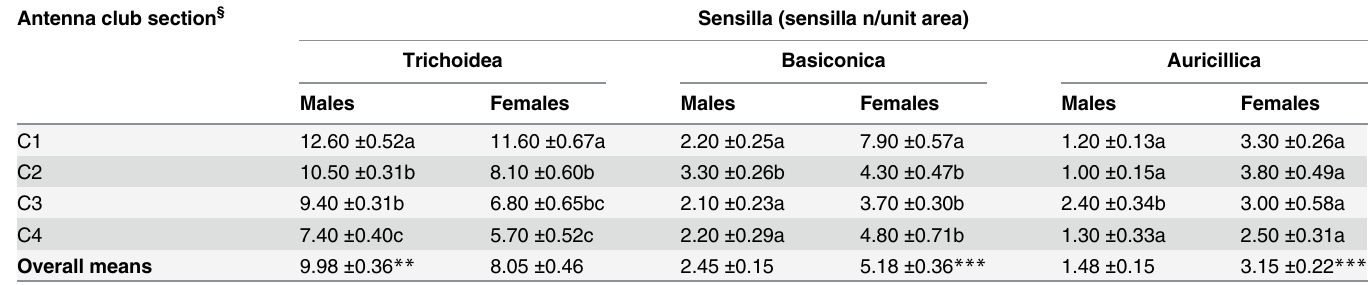
Table 2. Sensilla trichoidea, sensilla basiconica and sensilla auricilica in the different sections of the Paysandisia archon antenna club. Antenna club section